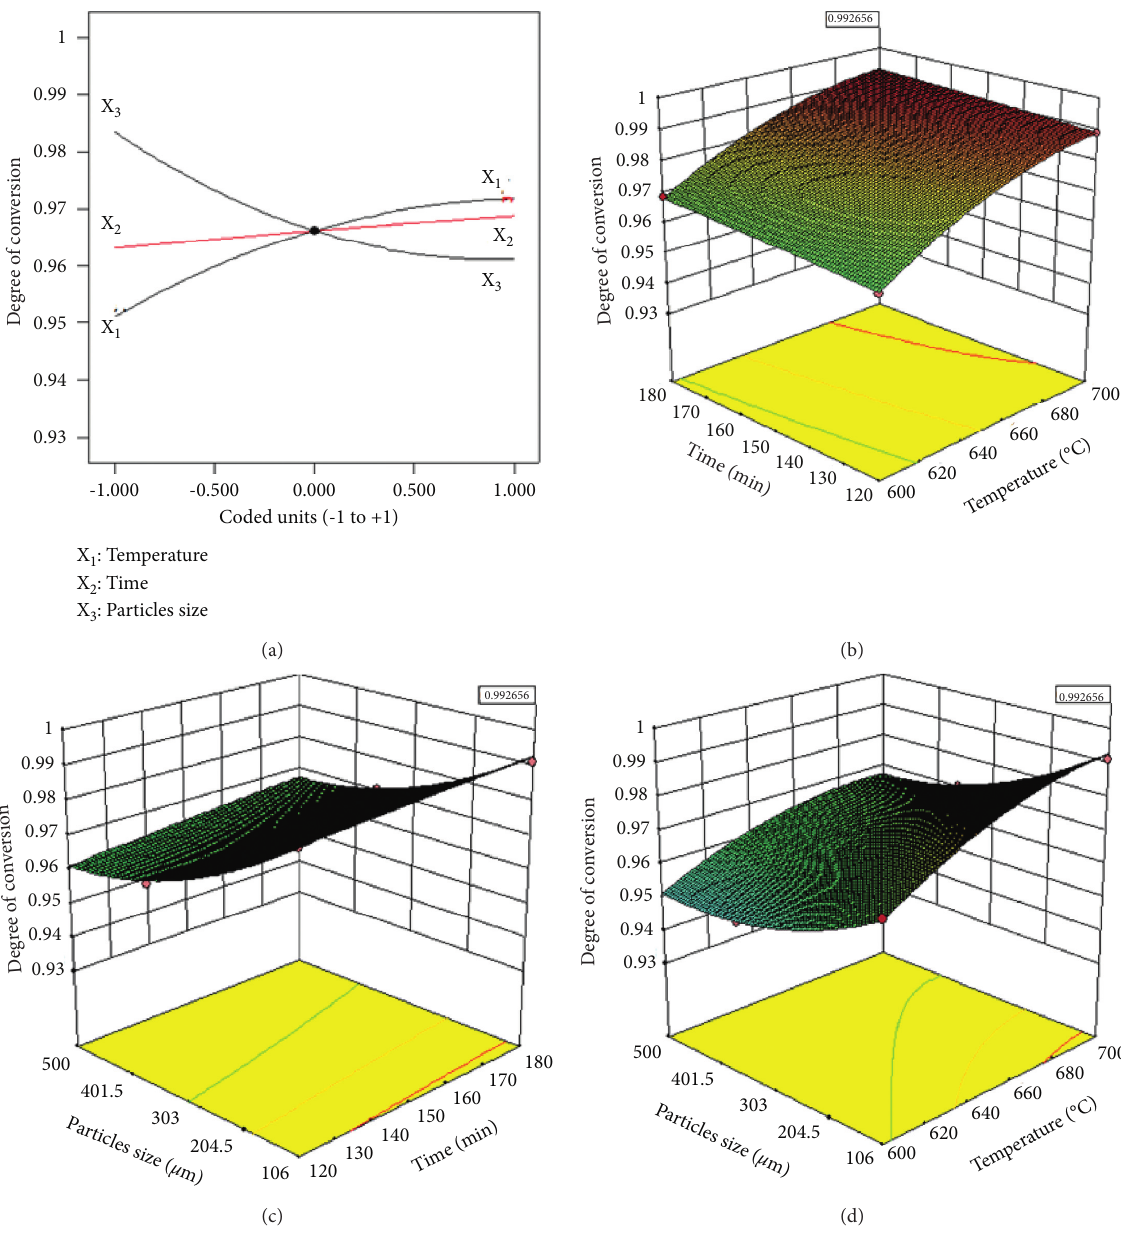
Figure 5: Model graphs of (a) perturbation plot of the factors effect on degree of conversion, (b) the surface plot of calcination temperature and time effect, (c) the surface plot of calcination time and particles size effect, and (d) the surface plot of calcination temperature and particles size effect on degree of